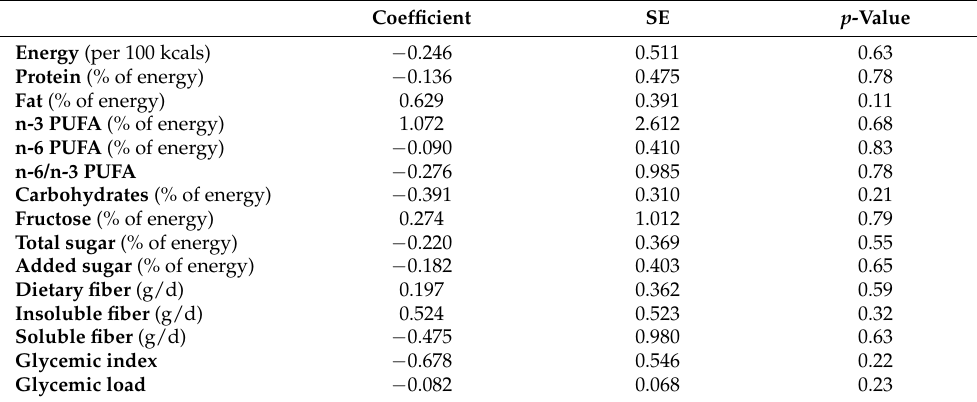
Table 3. Coefficients for the associations of dietary variables of interest with liver steatosis from separate multivariable linear regression